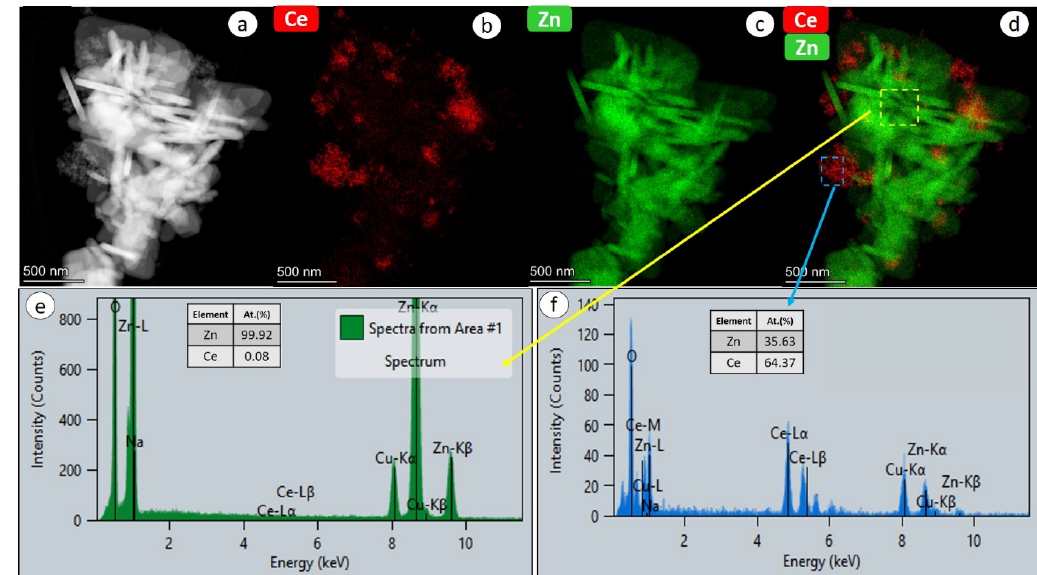
Figure 7. Sample ZnO:Ce 3% ( a ) HAADF-STEM image and the XEDS elemental maps showing the spatial distribution of ( b ) Ce, ( c ) Zn and ( d ) both elements together corresponding to the area displayed in ( a ), ( e , f ) and the XED spectra of the areas marked in ( d ).